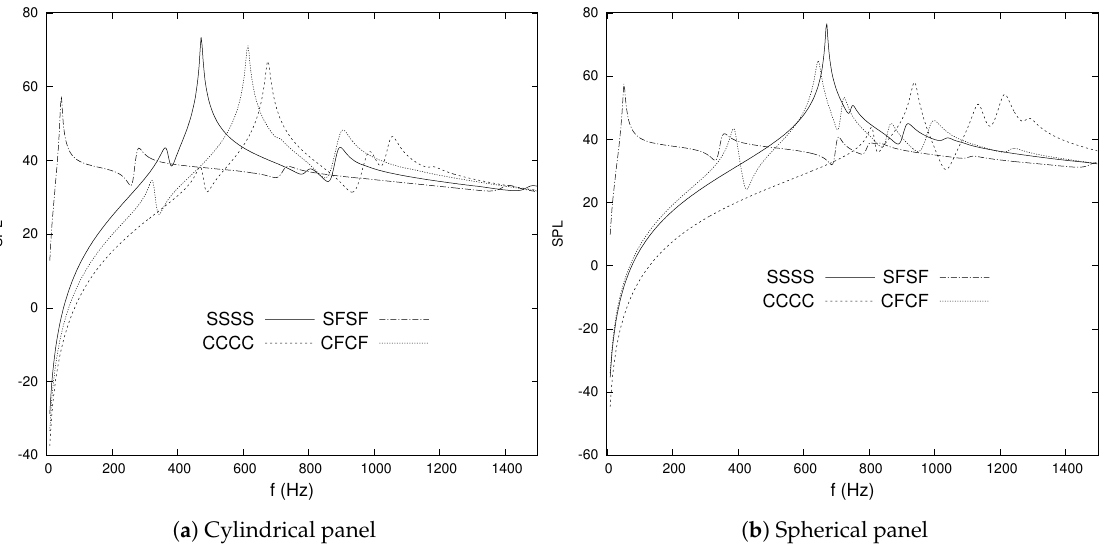
Figure 8. Transmitted sound power level ( SPL ) of the rectangular cylindrical and spherical shells with R α = R β = 1 m, for different boundary